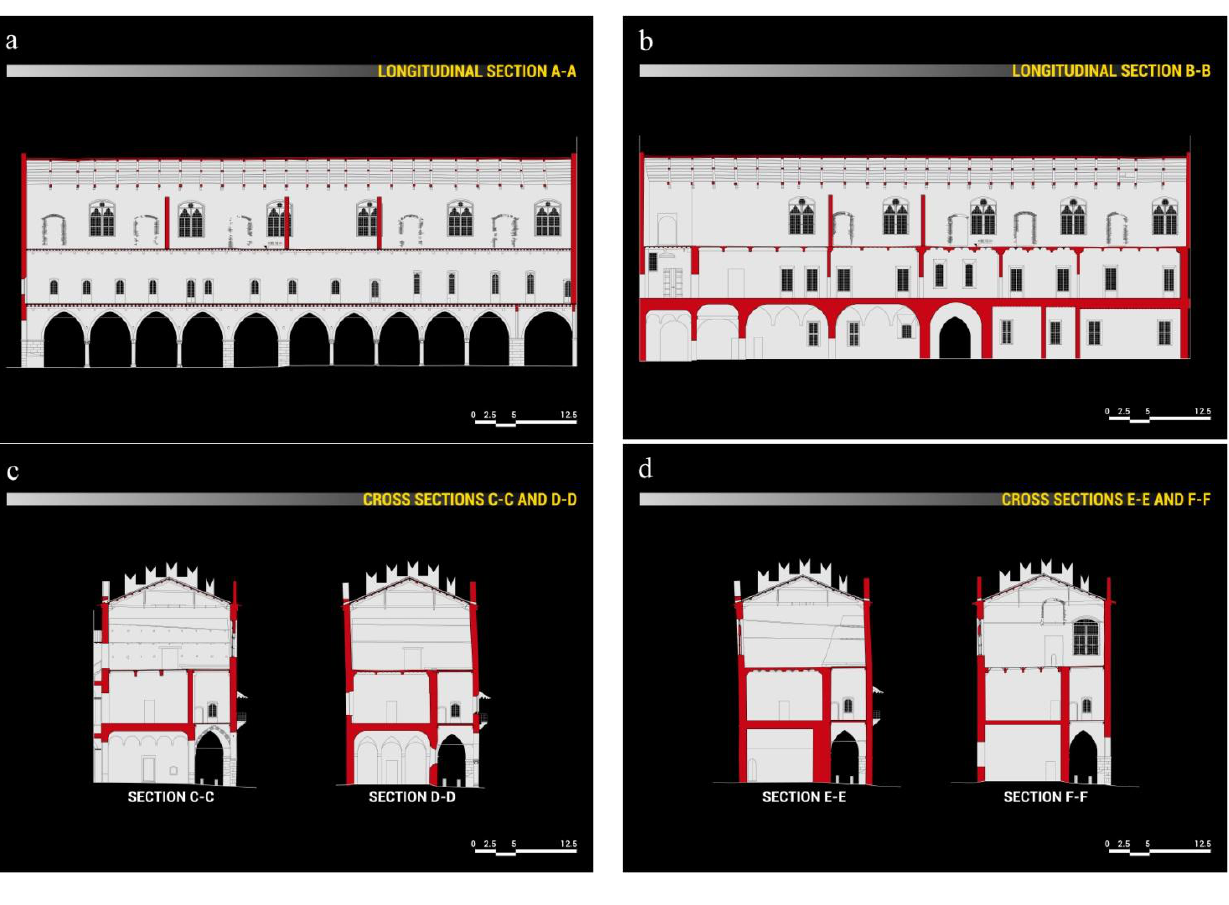
Figure 4. Palazzo del Capitano sections ( a ) Longitudinal section AA. ( b ) Longitudinal section BB. ( c ) Cross sections CC and DD. ( d ) Cross sections EE and